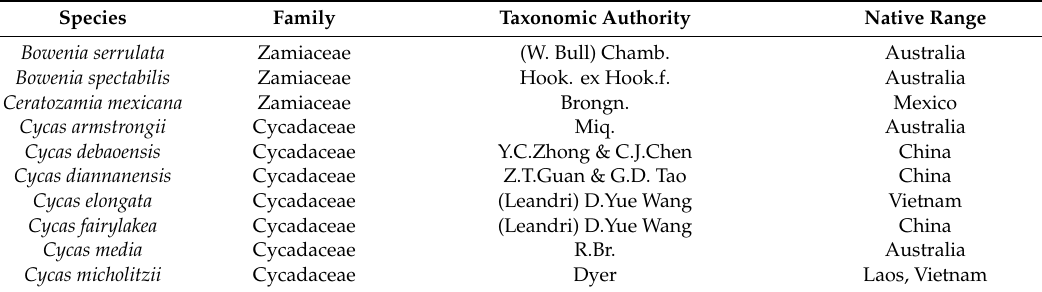
Table 1. Forty-six cycad species with reported leaf element